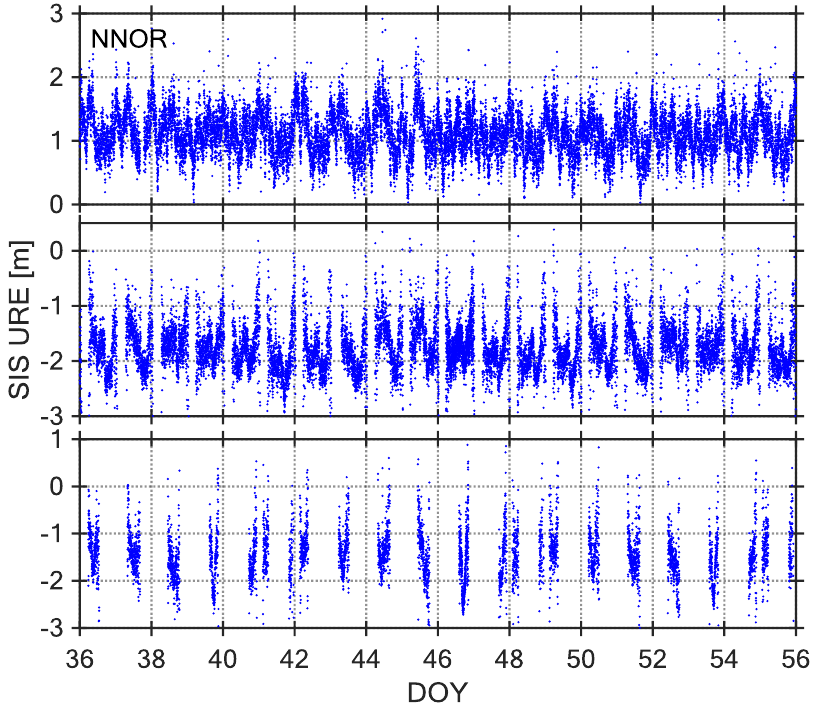
Figure 3. Signal-in-Space-User Range Error (SIS-URE) time series of Station NNOR, C04 ( top ), C09 ( middle ) and C14 ( bottom ), DOY 036–064, 2017.